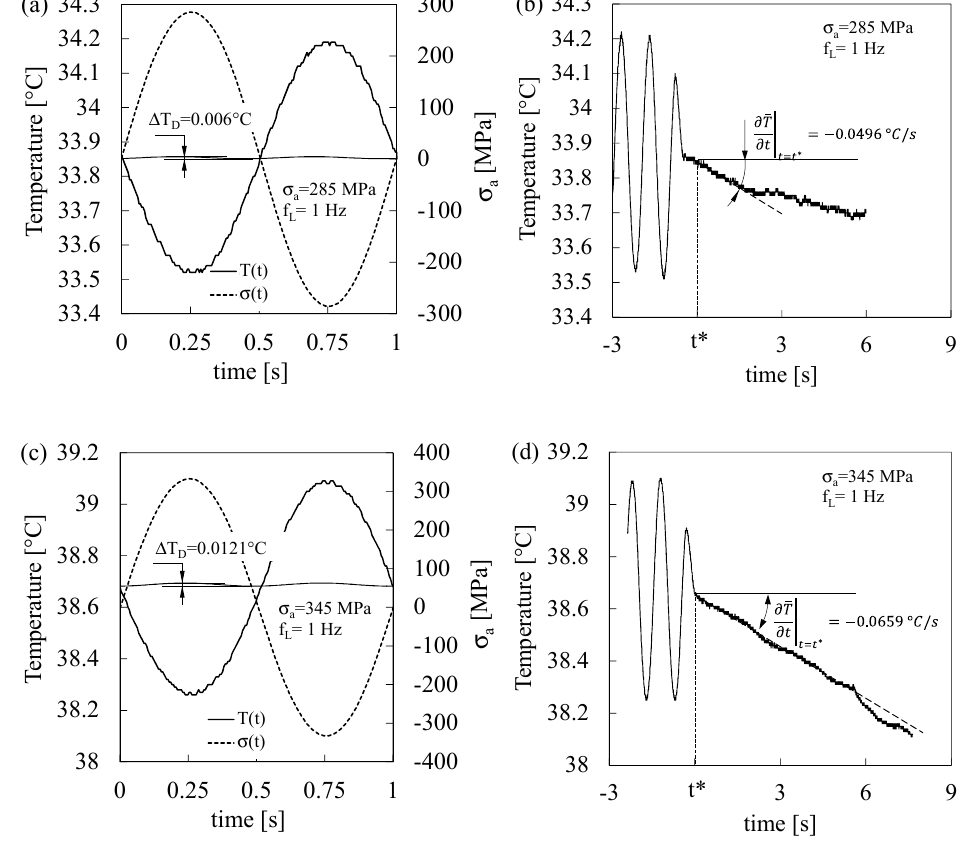
Figure 18. Example of ( a , c ) second harmonic of temperature signal and ( b , d ) cooling gradient during step-load tests at ( a , b ) σ a = 285 MPa and ( c , d ) σ a = 345 MPa.